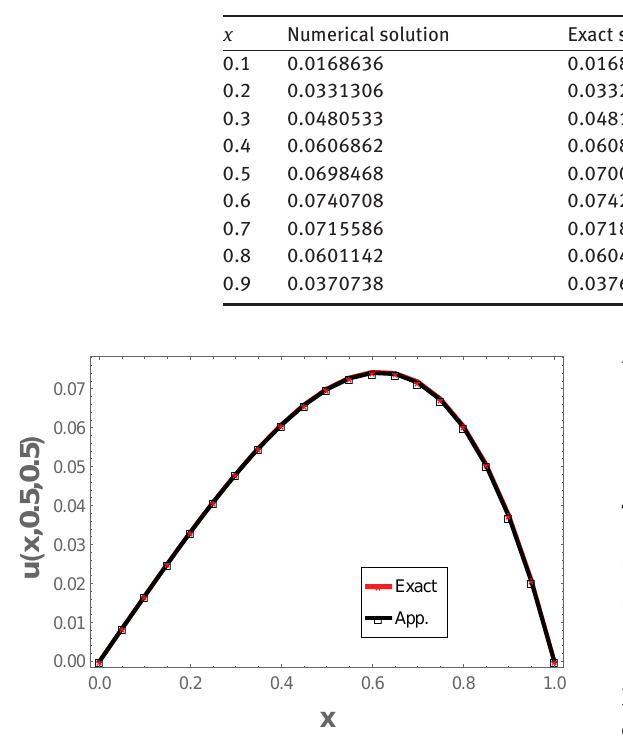
Figure 9: The numerical solutions with the exact solutions at y = z = 0.5 .